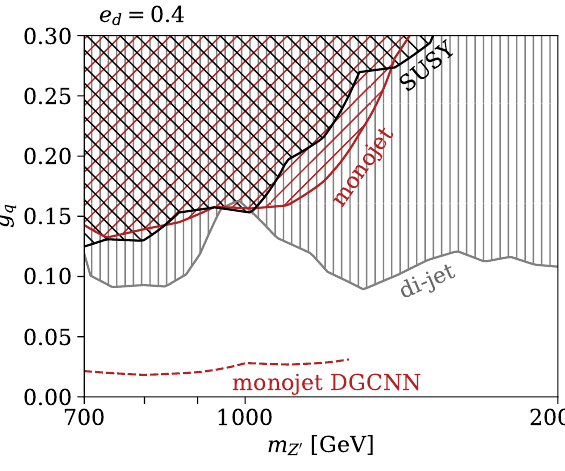
Figure 8: Expected limit on the benchmark model considered in this work from a mono-jet search [ 46 ] including a dynamic graph convolutional neural network dark shower tagger (labelled “monojet DGCNN"). The couplings of the Z (cid:48) mediator to dark quarks and SM quarks are denoted by e are taken from ref. [ 10 ]